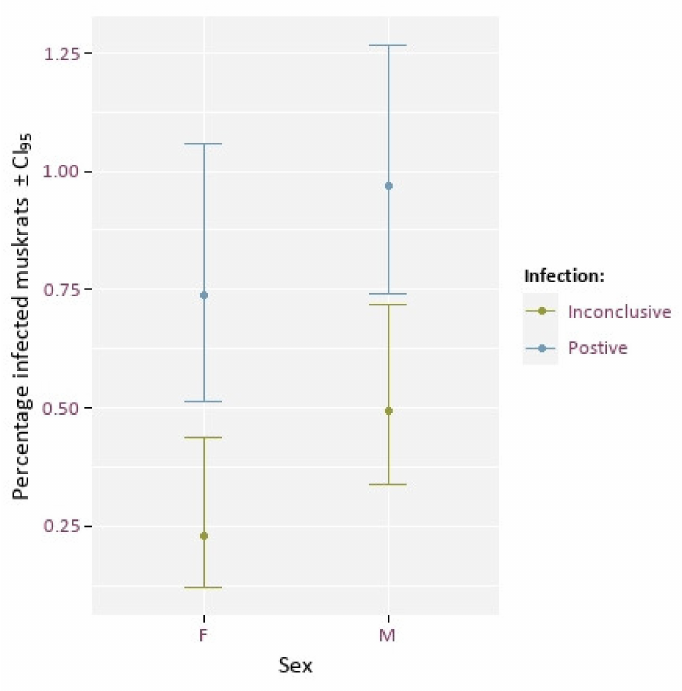
Figure 4. Percentage of muskrats with positive (blue) and inconclusive (green) EM presence by sex.